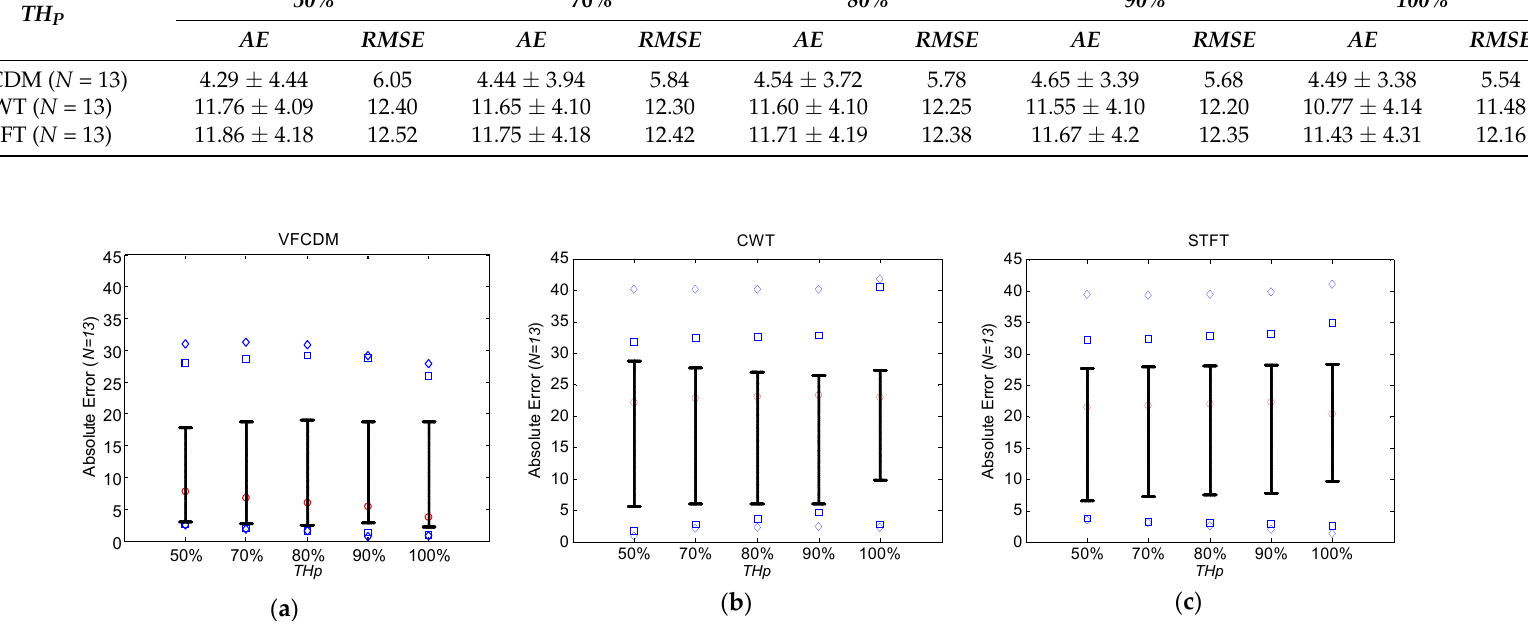
Table 3. Healthy subjects’ absolute errors (AE) and RMSEs of FEV 1 /FVC ratio according to TH P for VFCDM, CWT, and STFT methods.